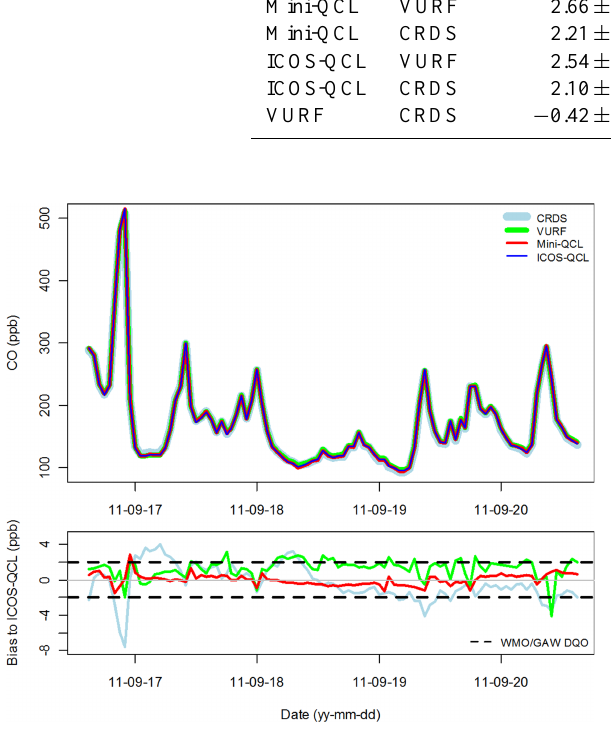
Fig. 13. Ambient air CO mole fractions measured with four different CO analysers from Friday, 16 September, to Tuesday, 20 September 2011 (upper panel), and difference to the ICOS-QCL analyser (lower panel). 1-h averages are